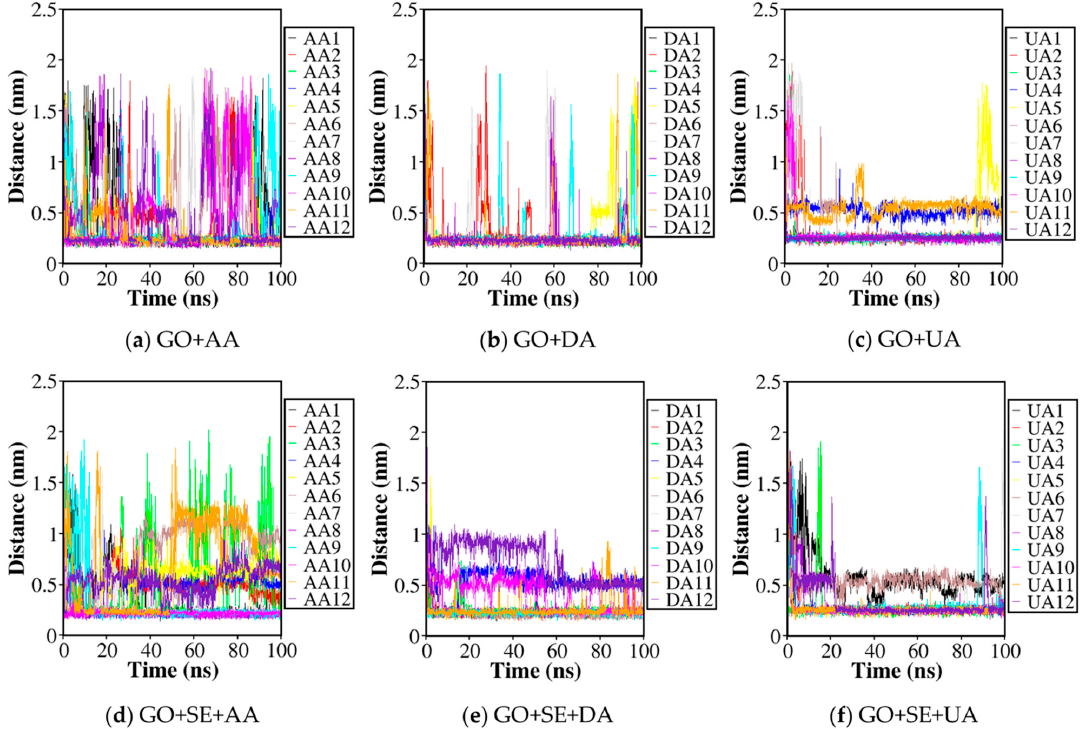
Figure 3. Minimum distances measured between each of the twelve analyte molecules and GO in the ( a ) GO + AA; ( b ) GO + DA; ( c ) GO + UA; ( d ) GO + SE + AA; ( e ) GO + SE + DA; and ( f ) GO + SE + UA systems. The final structure is also provided for each system. GO nanosheets are represented in grey and tetraserines are represented in orange.